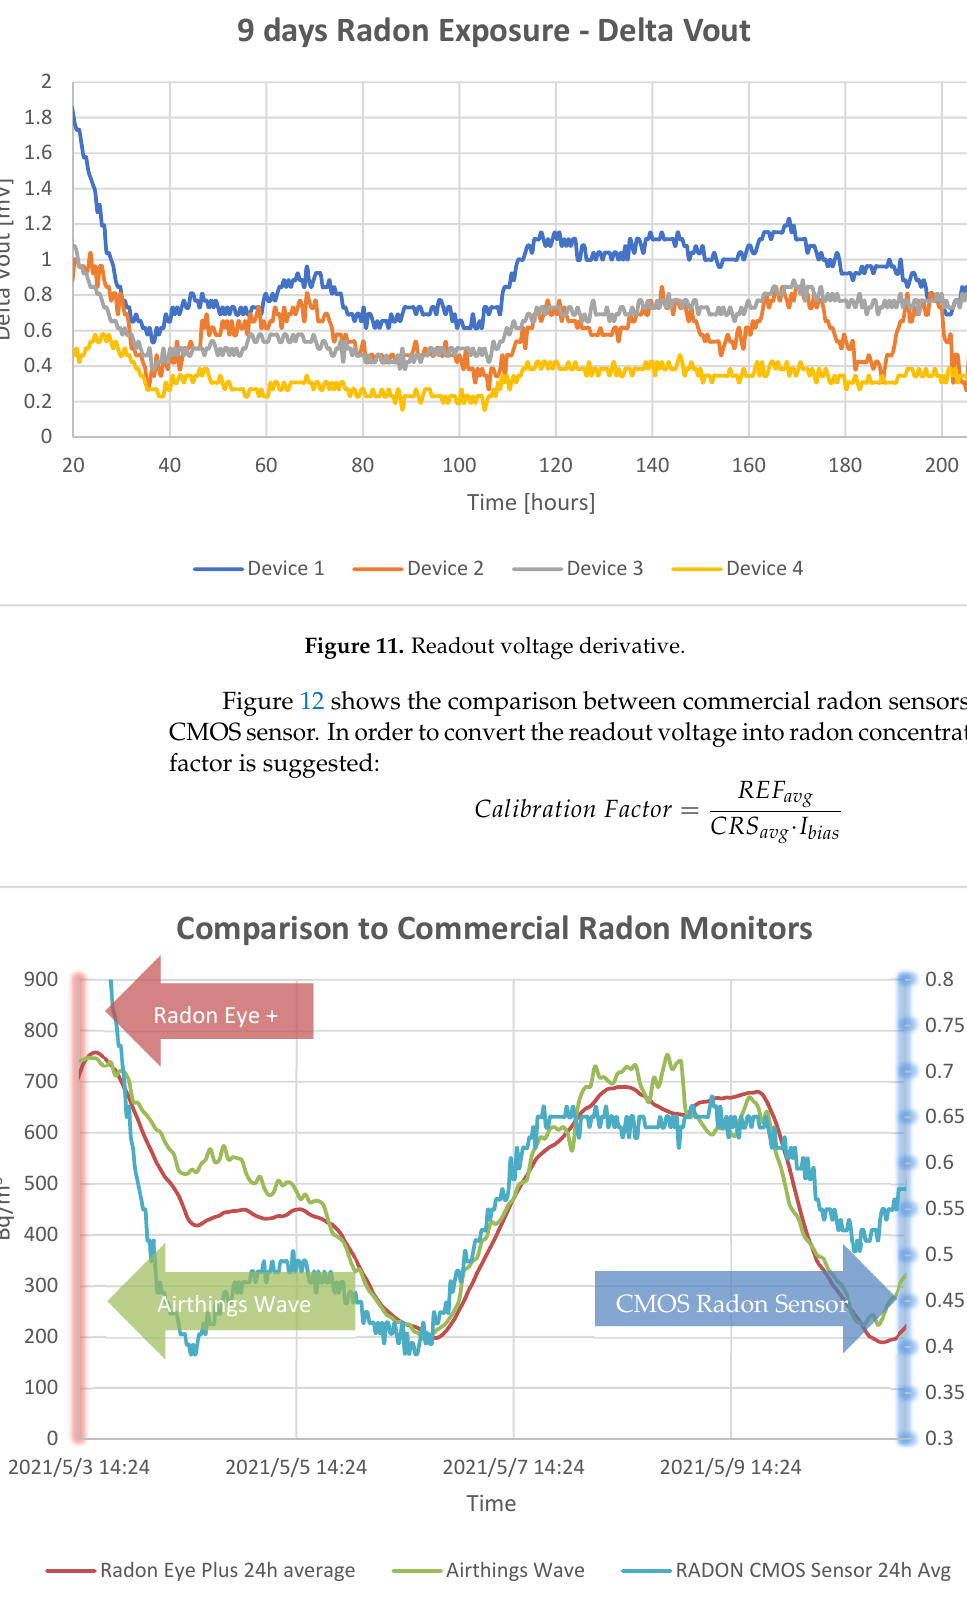
Figure 10. IV curve of blind and active arrays, before and after 9 days of Radon exposure.